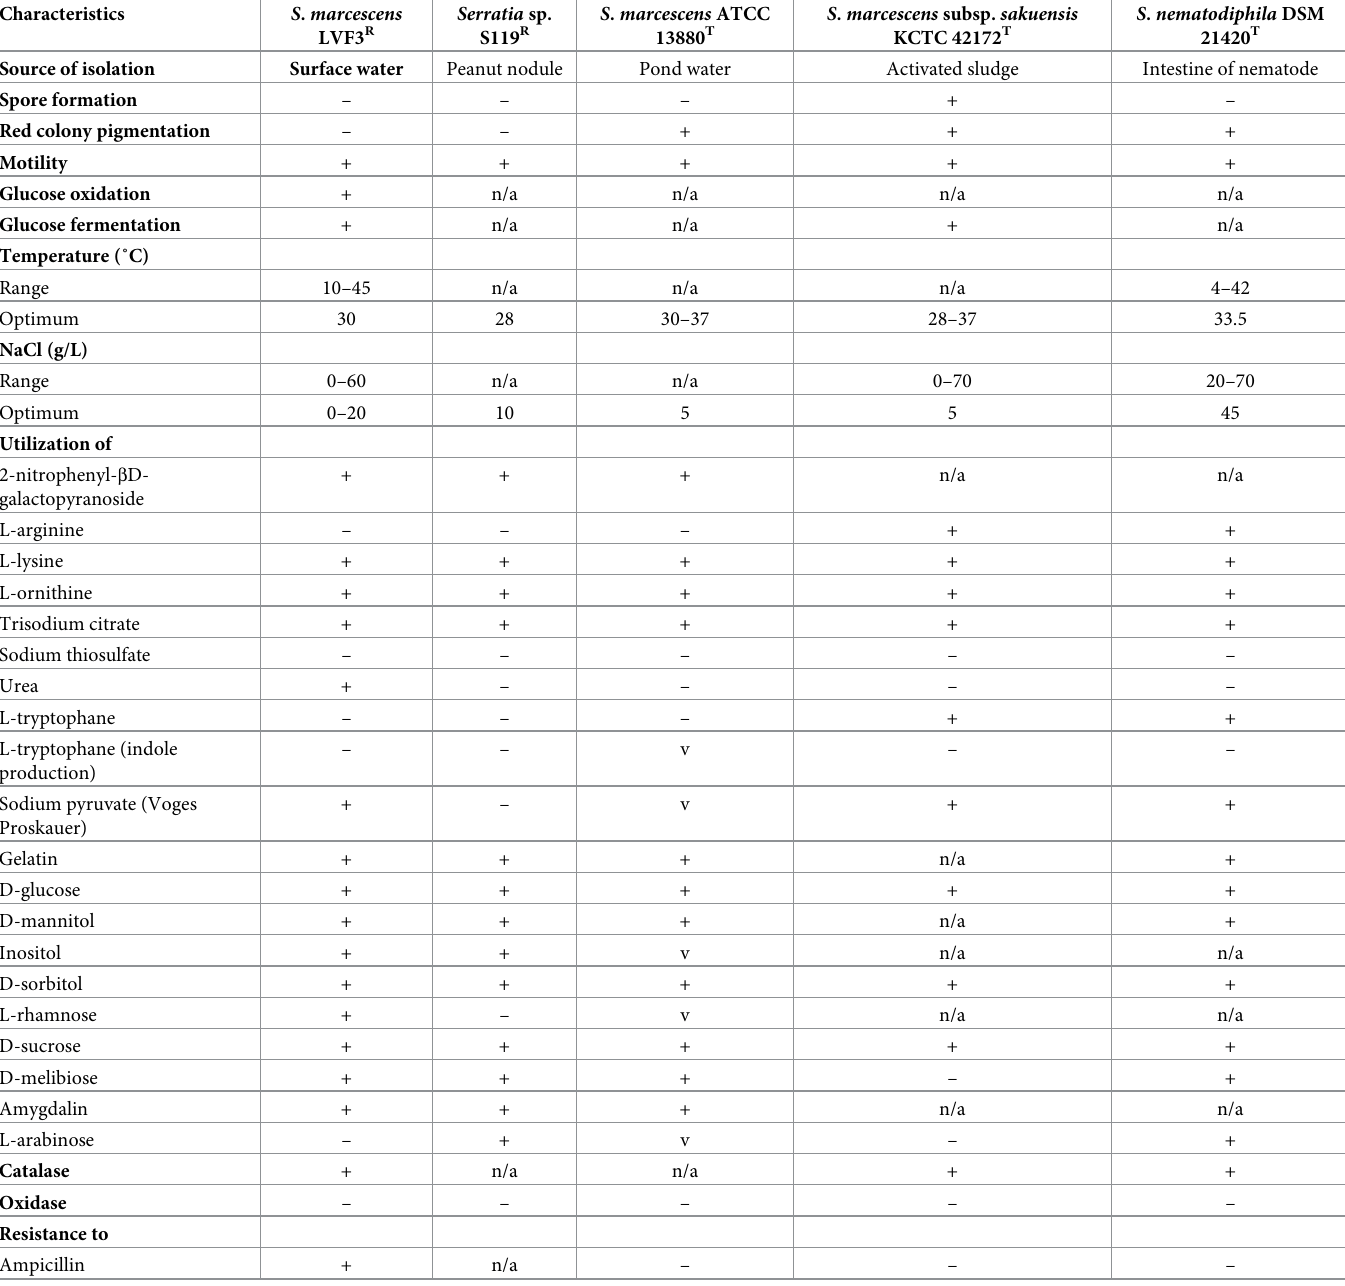
Table 1. Phenotypic characteristics of strain LVF3 R and phylogenetically related species Serratia sp. S119 R , S marcescens ATCC 13880 T , S . marcescens DSM 17174 R , S . nematodiphila DSM 21420 T